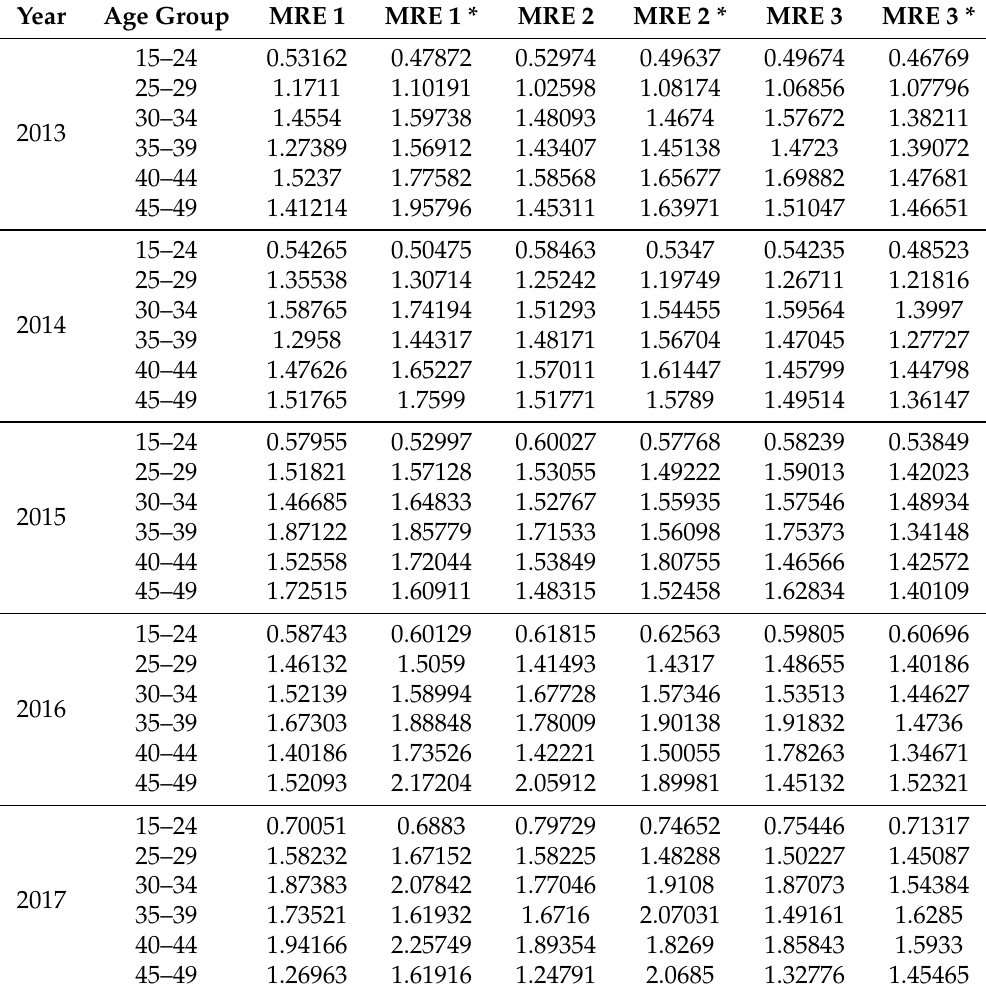
Table 6. Mean relative error for average incidence values in the female population compared between benchmark data and after calibration with HIV epidemiology and sexual behaviour (MRE 1), a phylogenetic tree (MRE 2), and a combination of the two types of features (MRE